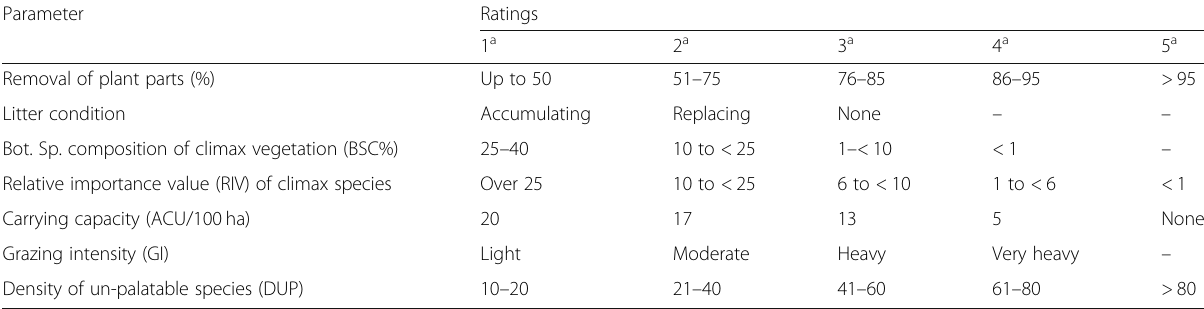
Table 2 Rating parameters of various qualitative attributes applied for land status at Jodhpur Parameter Ratings Removal of plant parts (%) Litter